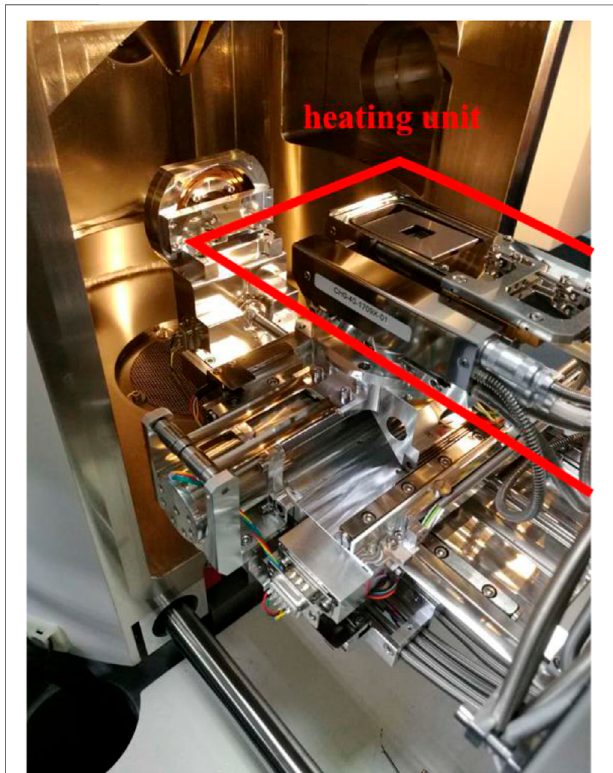
FIGURE 3 | The heating device in the scanning electron